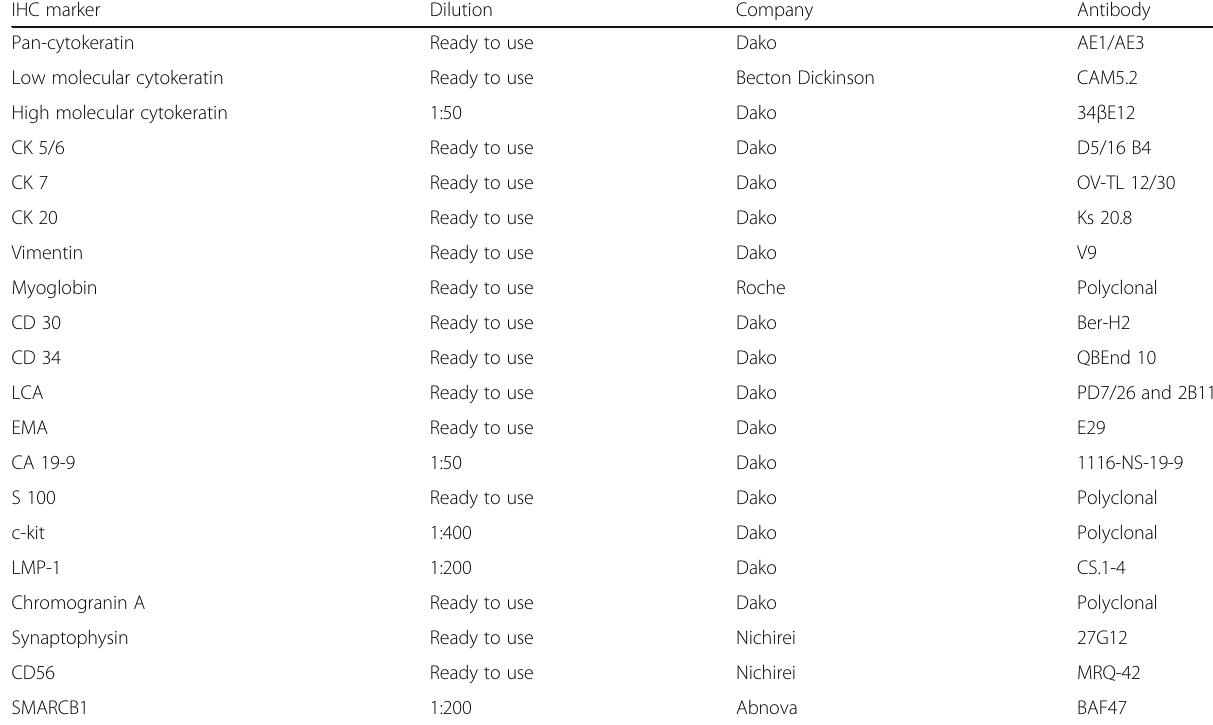
Table 1 Immunohistochemical antibodies used for tumor diagnosis IHC